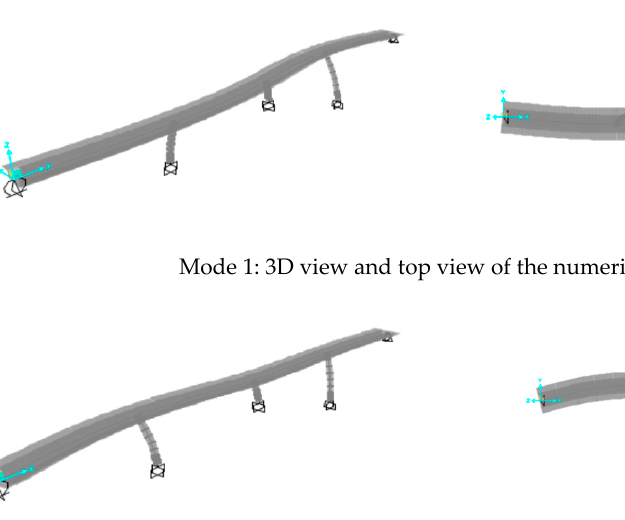
8 of 18 Figure 5. Bridge structural model. 3.4. Modal Properties According to the IMPAb procedure, a modal analysis of the bridge was performed in order to identify the relevant modal shapes in terms of period and participating mass. Results are summarized in Table 3 (the main mode is the 3rd, T = 0.53 s) and, in Figure 6, the modal deformed shapes of the deck (transversal direction) are plotted. The modes were selected following the indications of [34]; therefore, a lower bound of 3% for the participating mass was considered (modes having a lower value were neglected). The target cumulative participating mass was 90% and, considering mode 2, 3 and 4, the case study reached a value of 92.7%; the neglected modes were characterized by a participating mass lower than 1%. It is worth mentioning that for existing structures, modal characteristics can be retrieved using modal updating techniques [35]. Table 3. Modal analysis of the bridge: relevant modes in the transversal direction (mode 1, mode 3 and mode 4) having a participating mass ratio >3%. Mode Period [sec] Participating Mass [%]